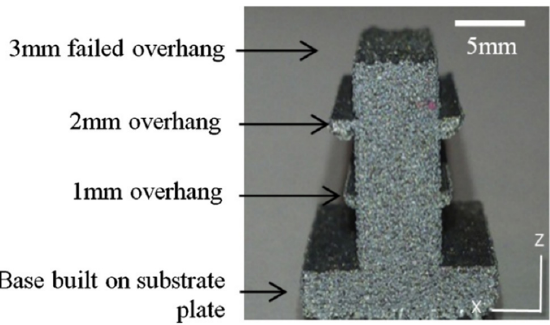
Figure 2. ASLM overhanging part constructed at 100 ◦ C (Vora et al., 2015 [18]).